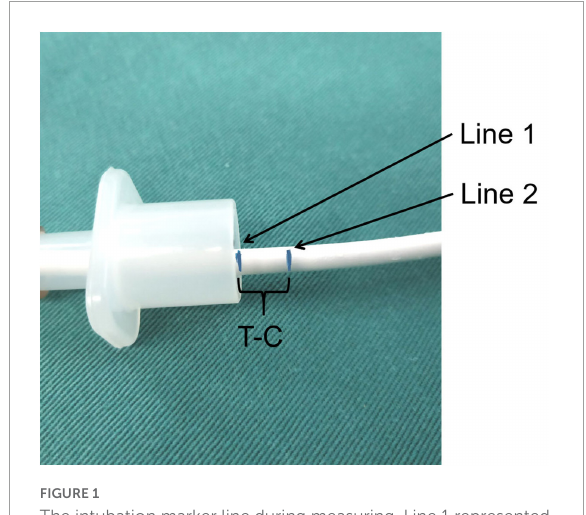
FIGURE1 The intubation marker line during measuring. Line 1 represented that the tip of the endoscope arrived at the carina. Line 2 represented that the tip of the endoscope arrived at the tip of the